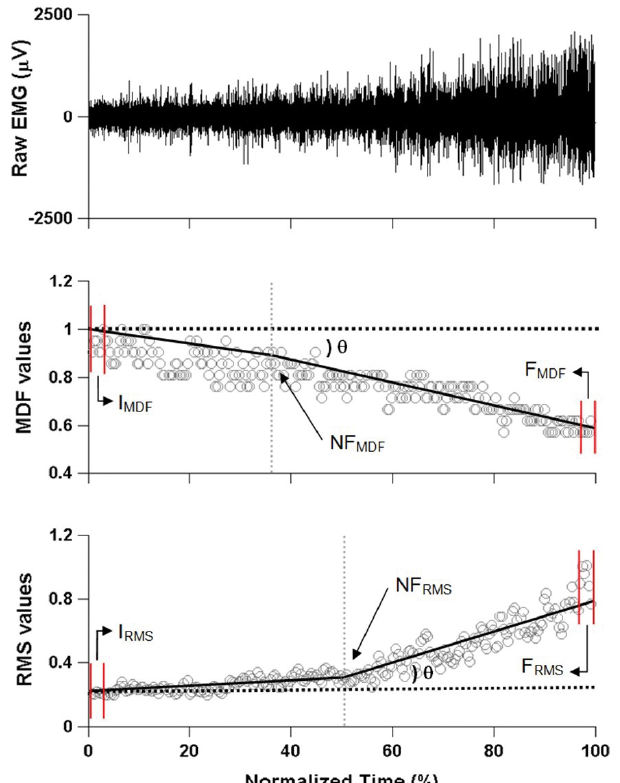
Figure 1. Example of the methodology used in the NF determination during a fatigue test at 20%